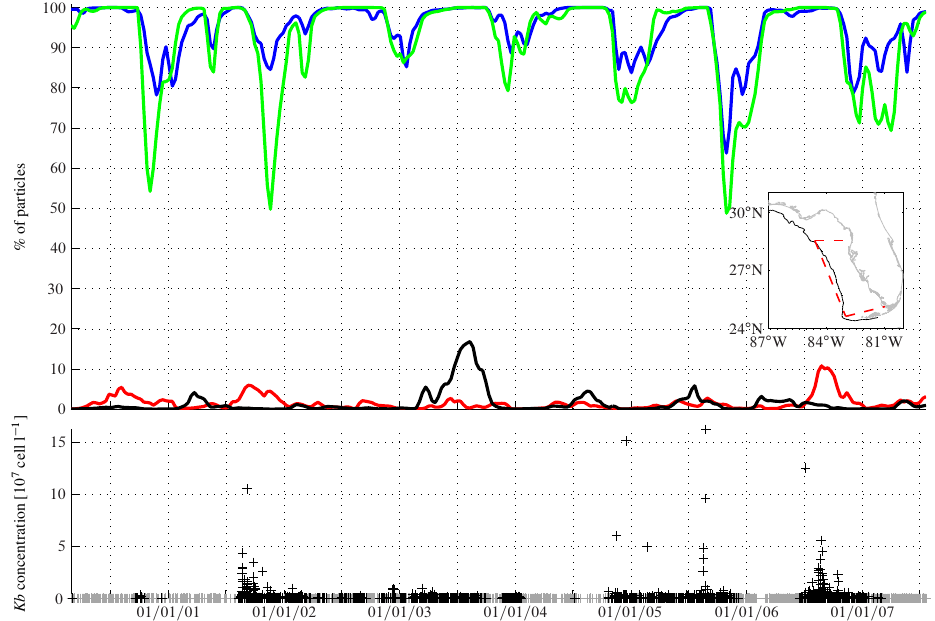
Fig. 6. Top panel: percentages as a function of time of passive particles that reach the region on the WFS delimited by the dashed-red line indicated in the inserted map after being released every other day on the surface layer (black curve) and subsurface layer k = 6 (red curve) in region M, and on the surface in region T (blue curve) and C (green curve), as indicated in the top-left panel of Fig. 5. Subsurface particle percentages are multiplied by ten. The black curve in the inserted map indicates the 60-m isobath. Bottom panel: time series of Karenia brevis cell concentration within the control region on the WFS. Highlighted in black is cell concentration higher than 10 4 celll − 1 , which is a threshold concentration used as a red tide indicator.